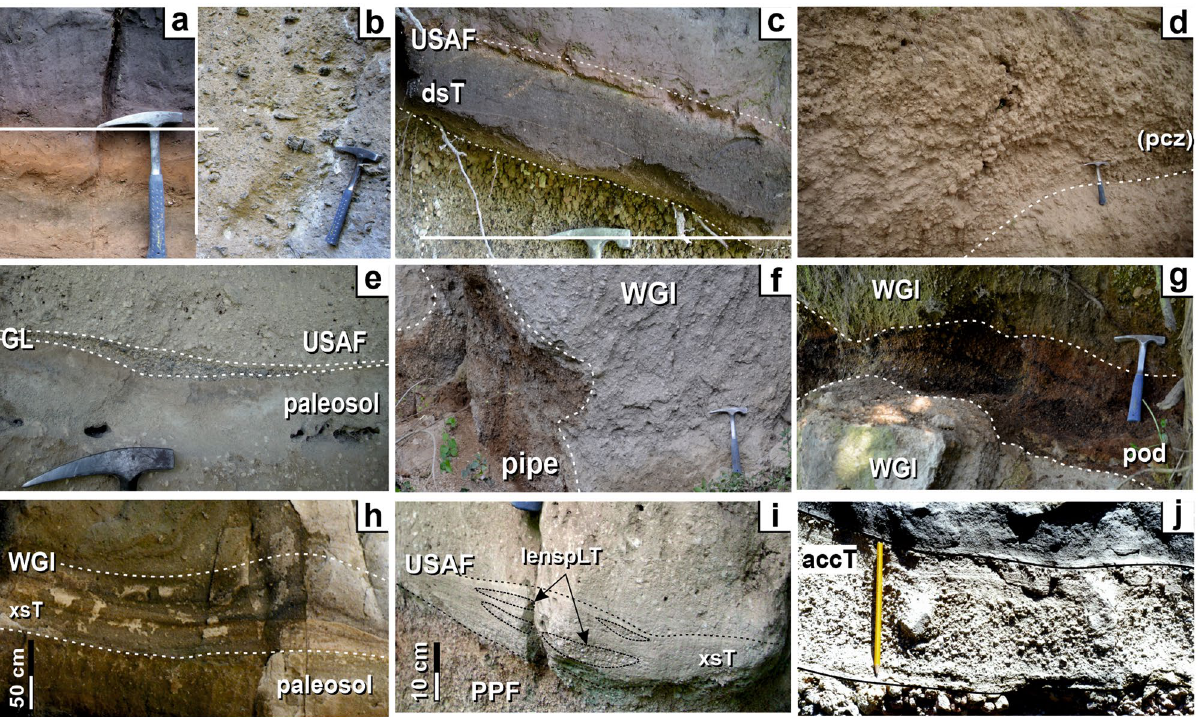
Figure 3. Lithofacies recognized in the medial pyroclastic current deposits of the Campania Ignimbrite eruption: ( a ) Massive tuff; ( b ) Massive lapilli tuff; ( c ) Diffuse-stratified tuff; ( d ) Pumice-rich lapilli tuff showing a pumice concentration (pcz) zone at the top; Fines-poor lithic lapilli tuff occurs as Ground Layer, GL ( e ), at the base of the ignimbrite sequence or pipes ( f ) and pods ( g ) intercalated in the main ignimbrite body (WGI unit); Cross-stratified tuff lithofacies is characterized by cross-stratification/lamination and bedforms with wavelength from 4 m ( h ) to few centimeters ( i ). Pockets of fines-poor, sub-angular, fine pumice lapilli may be present between the laminae of small bedforms forming the “Lenses of pumice lapilli” lithofacies ( i ); ( j ) Accretionary lapilli-bearing lithofacies. Figure is generated using CorelDRAW Graphics Suite 2020 for Windows v. 22.0.0.412 (https ://www.corel draw.com/it/produ ct/corel draw/).